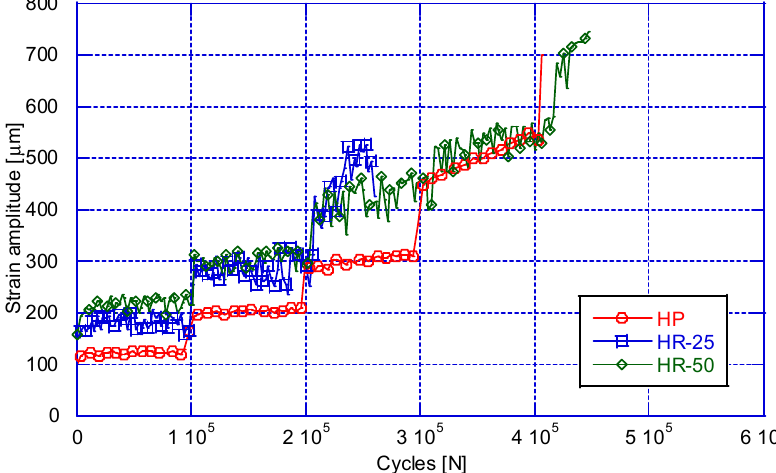
Figure 5. Strain amplitude evolution during a Locati test on the OPC mixes.